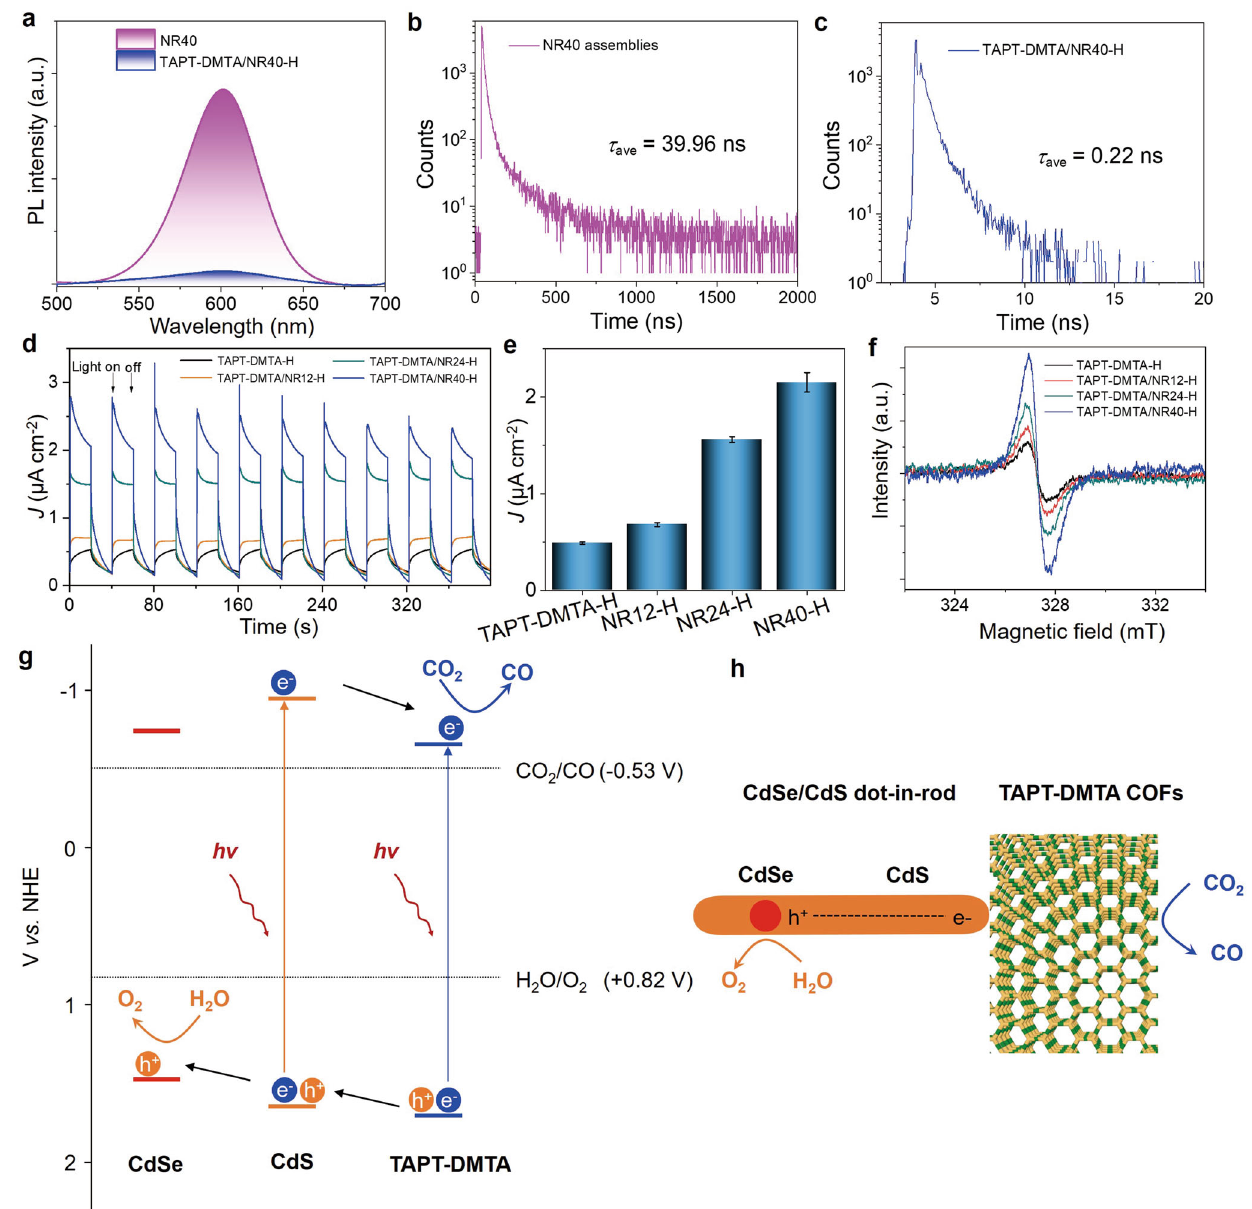
Fig. 4 | Photogenerated charge transfer properties. a Steady-state PL spectra of NR40 and TAPT-DMTA/NR40-H. b Time-resolved PL spectra of NR40 assemblies. c Time resolved PL spectra of TAPT-DMTA/NR40-H. d Transient photocurrent response and the corresponding data statistics ( e ) ofTAPT-DMTA-H, TAPT-DMTA/ NR12-H, TAPT-DMTA/NR24-H, and TAPT-DMTA/NR40-H; error bars arestandard